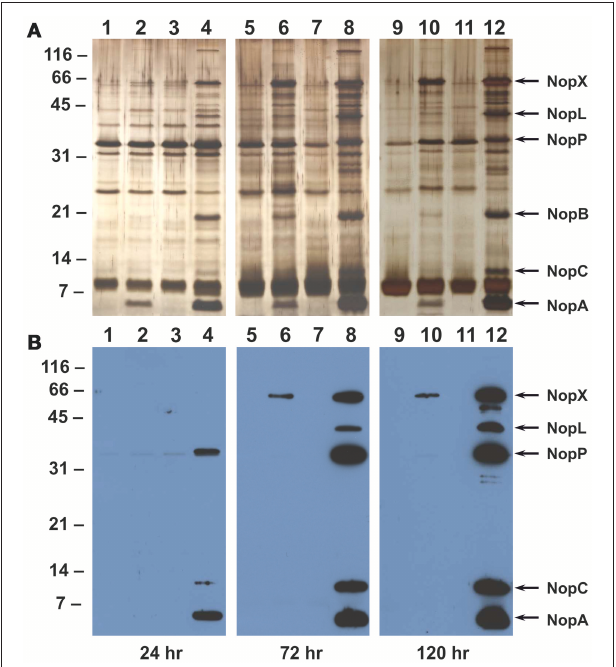
FIGURE 3 | Extracellular protein profile and immunoblot analysis of Sinorhizobium fredii NGR234 and NGR234- △ traI - △ ngrI double deletion mutant. Extracellular proteins isolated from cells grown in the absence (odd number lanes) or presence (even numbered lanes) of 1 µ M apigenin were resolved by 15% SDS-PAGE and silver stained (A) or transferred to nitrocellulose membrane (B) for immunological analysis with a cocktail of antibodies raised against the individual Nop proteins. Lanes 1–4 contain protein samples harvested from 24 h, lanes 5–8 from 72 h, and lanes 9–12 from120 h old cultures. The size of the molecular weight markers in kDa and the identity of the immunoreactive proteins are also shown.